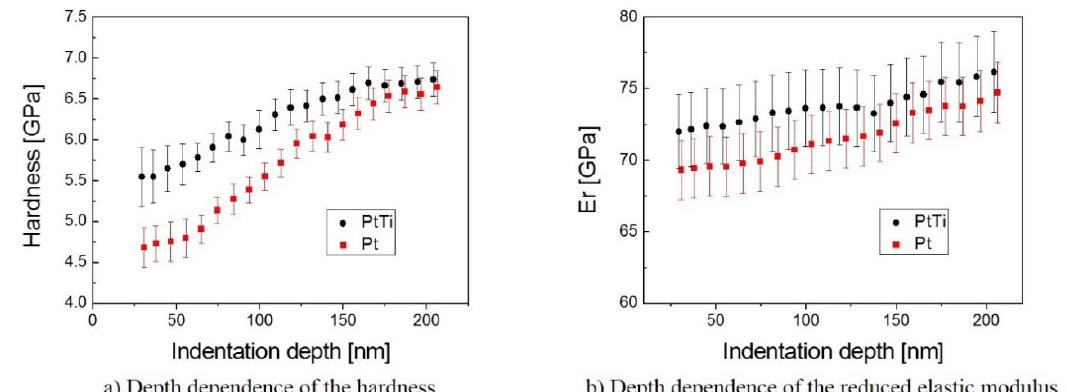
Figure 5. Results of the nanoindentation tests in the range of indentation loads from 0.5 to 10 mN. ( a ) Depth dependence of the hardness and ( b ) Depth dependence of the reduced elastic modulus.